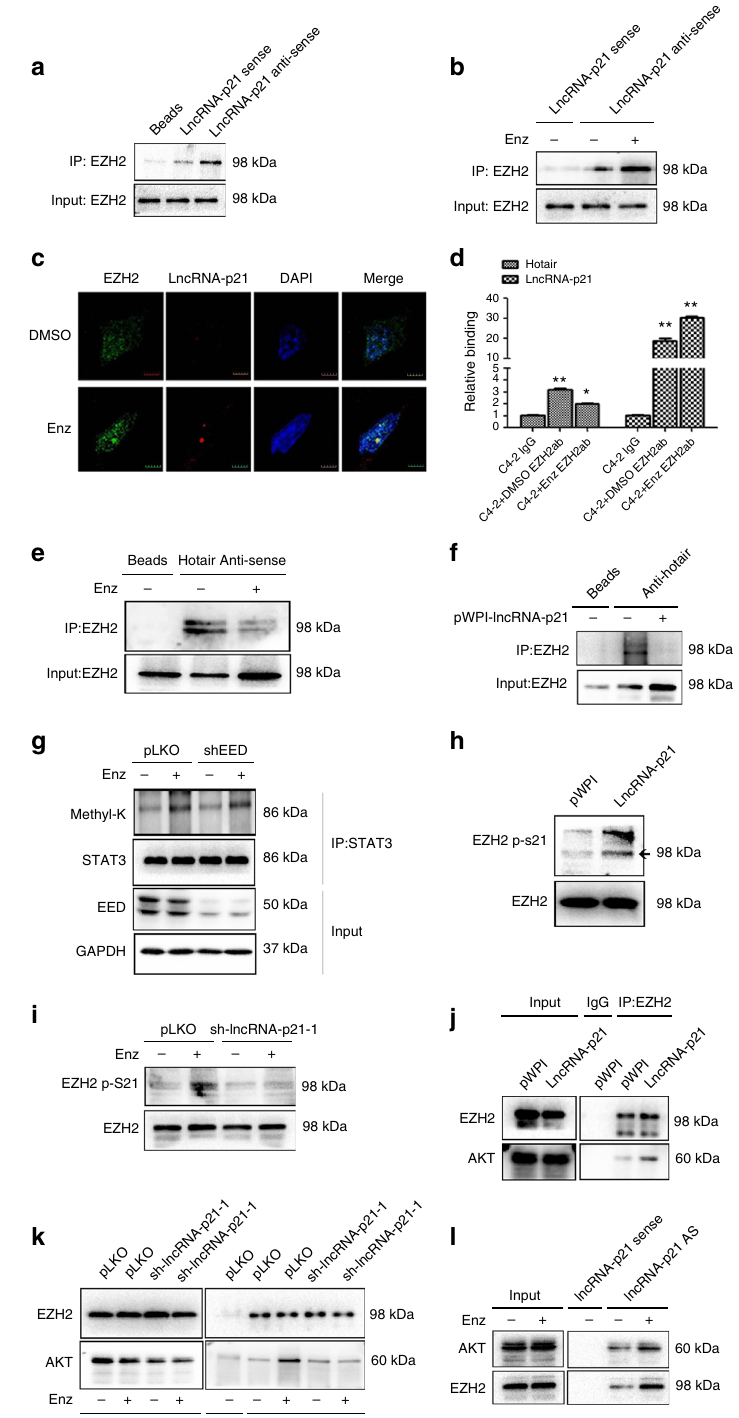
Fig. 6 The lncRNA-p21 competes with Hotair to interact with EZH2 and promotes phosphorylation of EZH2 at S21. a , b RNA-IP was performed to detect the lncRNA-p21 interaction with EZH2 by using lncRNA-p21 anti-sense probe vs sense probe in ( a ) C4-2 cells and in ( b ) Enz-treated C4-2 cells. c RNA in situ hybridization and immuno fl uorescent staining to detect the co-localization of lncRNA-p21 and EZH2 in C4-2 cells w/o Enz treatment (Scale bar = 2 μ m). d In C4-2 cells, the EZH2 was pulled down by EZH2 antibody and the levels of lncRNA-p21 and Hotair were detected by qPCR. e , f RNA-IP assay to detect the interaction between Hotair and EZH2 after treating w/o Enz ( e ) and w/o overexpression of lncRNA-p21. f , g STAT3 methylation levels were detected by WB in C4-2 pLKO and sh-EED cells after 4 days w/o Enz treatment. h EZH2 p-S21 levels were detected in C4-2 PWPI and PWPI-lncRNA-p21 cells. i EZH2 p-S21 level was detected in C4-2 pLKO and sh-lncRNA-p21 cells w/o Enz treatment. j The Co-IP assay to detect the AKT and EZH2 interaction in C4-2 pWPI and C4-2 pWPI-lncRNA-p21 cells. k C4-2 pLKO and sh-lncRNA-p21 cells were treated w/o Enz for 4 days and then EZH2 was immunoprecipitated. The AKT and EZH2 interaction was analyzed by WB. l C4-2 cells were treated w/o Enz, and then the lncRNA-p21 was pulled down. The interaction of AKT and EZH2 with lncRNA-p21 was analyzed by WB. For d , the data are presented as mean ± SD, * p < 0.05, ** p < 0.005, by ANOVA NATURE COMMUNICATIONS| (2019) 10:2571